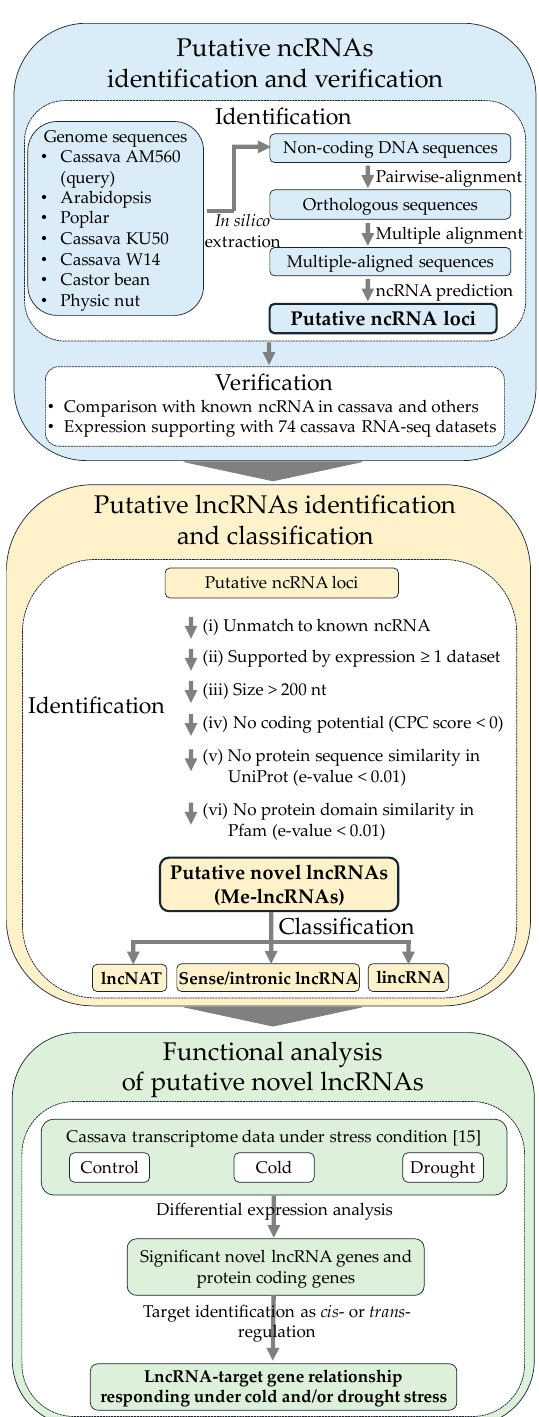
Figure 1. Overview of workflow for putative non-coding RNAs’ (ncRNAs) identification and verification, putative long non-coding RNAs’ (lncRNAs) identification and classification, and functional analysis of putative novel lncRNAs. LncNAT: long non-coding natural antisense transcript. Sense/intronic lncRNA: Sense/intronic long non-coding RNA. LincRNA: long intergenic non-coding RNA. CPC score: Coding potential calculation score.